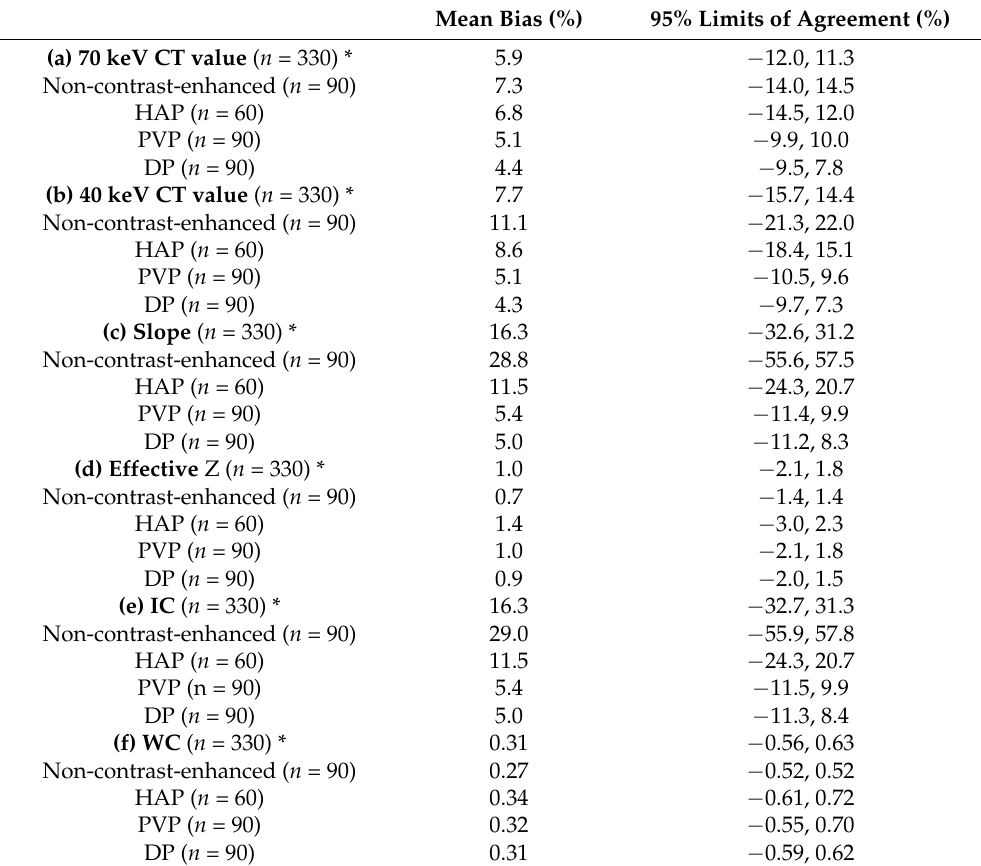
Table 1. Bland–Altman tests of the agreement between two ROIs within the same organ (liver, spleen, and